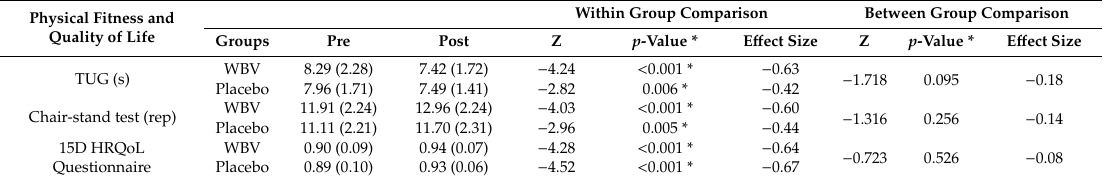
Table 5. Intent-to-treat of 8-weeks WBV training in the TUG, chair stand test and 15-D HRQoL